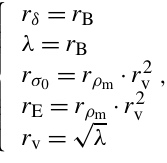
height and impact velocity on the barrier. Four load cells were installed at the plate vertices to measure the normal thrust acting on the